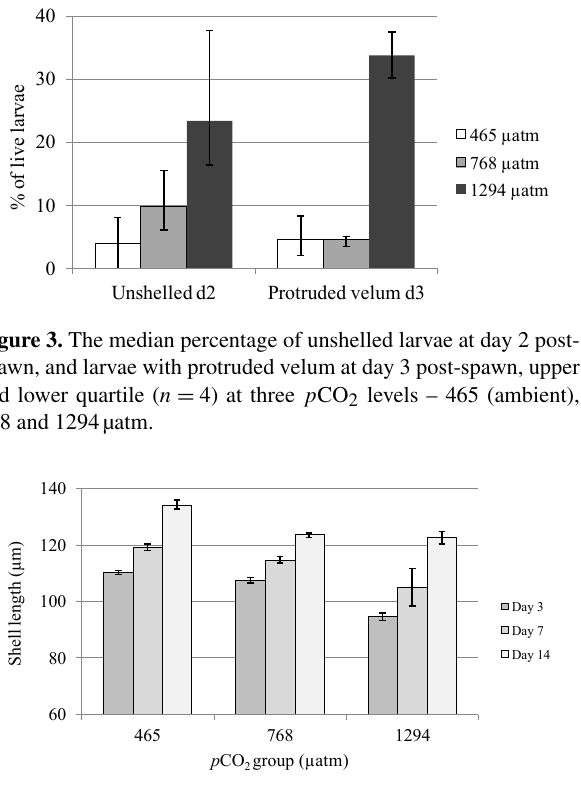
Figure 4. Mean shell length (µm) and standard deviation ( n = 4) for larvae at three p CO 2 levels – 465 (ambient), 768 and 1294µatm – at days 3, 7 and 14